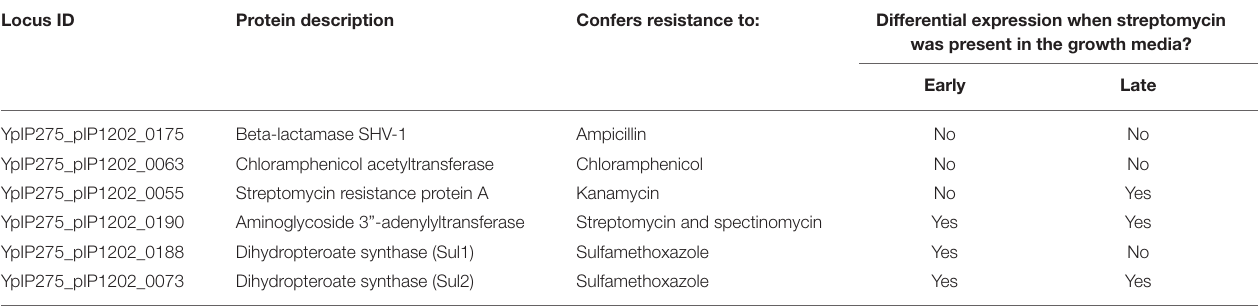
TABLE 5 | Antimicrobial resistance-conferring proteins encoded on the Y. pestis MDR plasmid pIP1202 that were observed in this study and their differential expression in the presence of streptomycin. Locus ID Protein description Confers resistance to: Differential expression when streptomycin